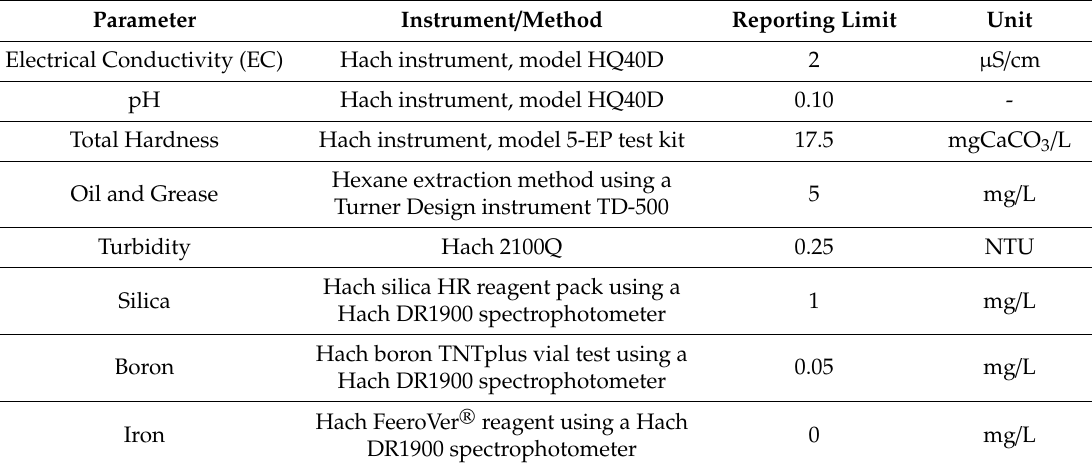
Table A1. List of onsite analysis, methods and reporting limits.